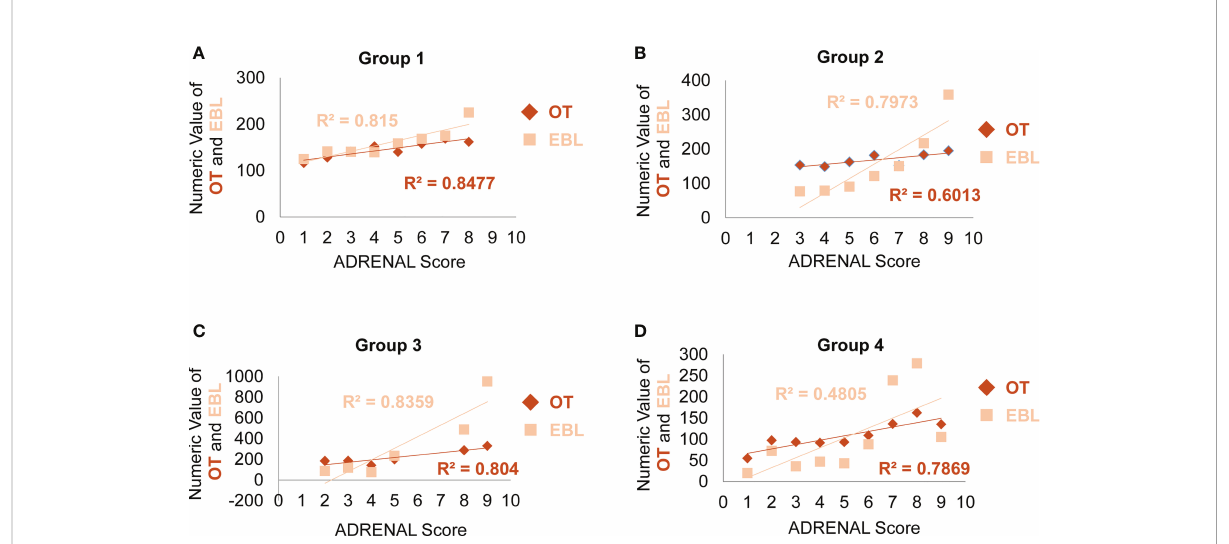
FIGURE 3 Analysis of the correlation between the ADRENAL score verse OT and EBL. In linear regression model, the correlation between the ADRENAL score and OT or EBL was tested in Group 1 (A) , Group 2 (B) and Group 3 (C) and Group 4 (D) . An R 2 > 0.5 was considered a signi fi cant